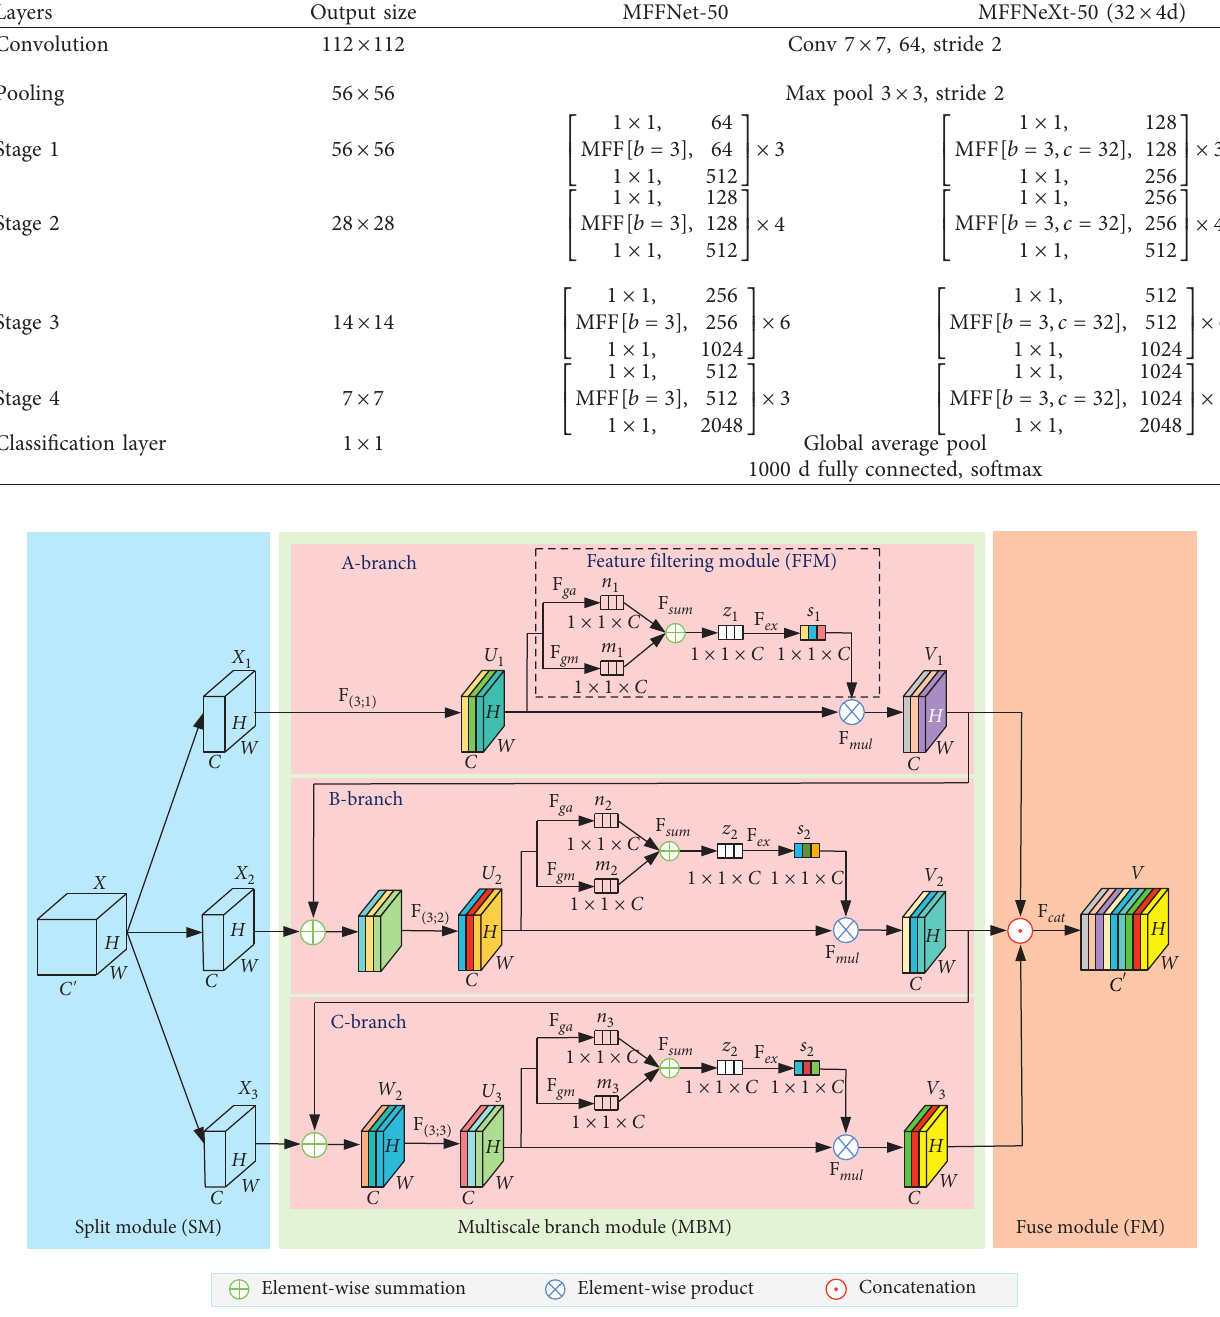
Figure 3: The structure of the multiscale feature filtering (MFF) module.